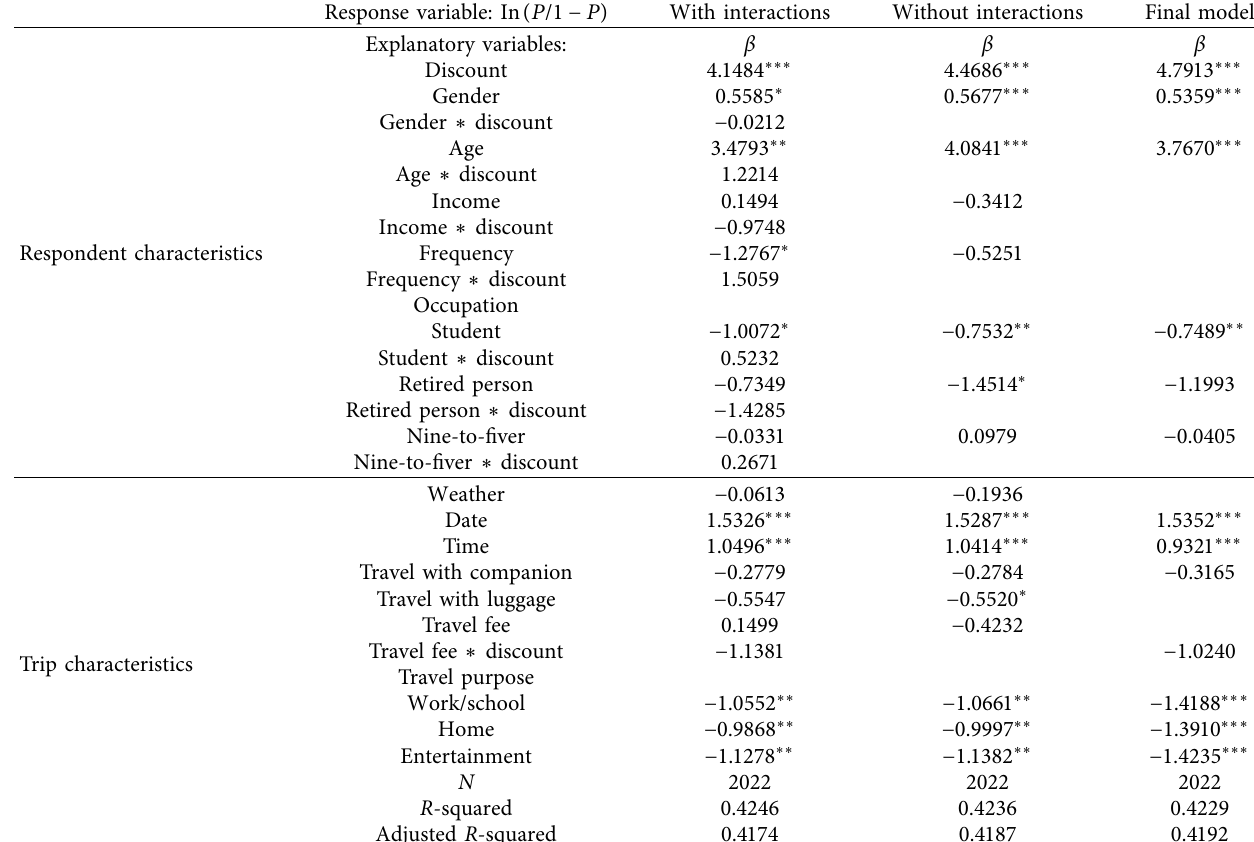
Table 6: Logistic regression: response variable In ( P /1 − P ) .